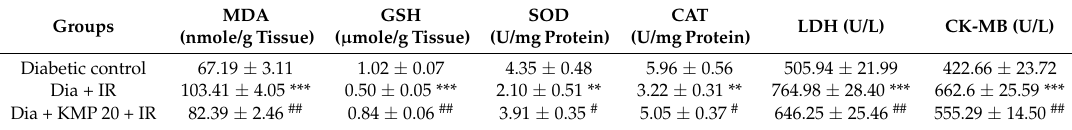
Table 3. Effect of kaempferol on oxidant-antioxidant parameters and cardiac injury markers. MDA: malondialdehyde; GSH: reduced glutathione; SOD: superoxide dismutase; CAT: catalase; LDH: lactate dehydrogenase; CK-MB: creatine kinase-MB isoenzyme. Data are expressed as mean ± S.E.M.; n = 6 in each group. ** p < 0.01, *** p < 0.001 vs. Diabetic control; # p < 0.05, ## p < 0.01 vs. Dia + IR.